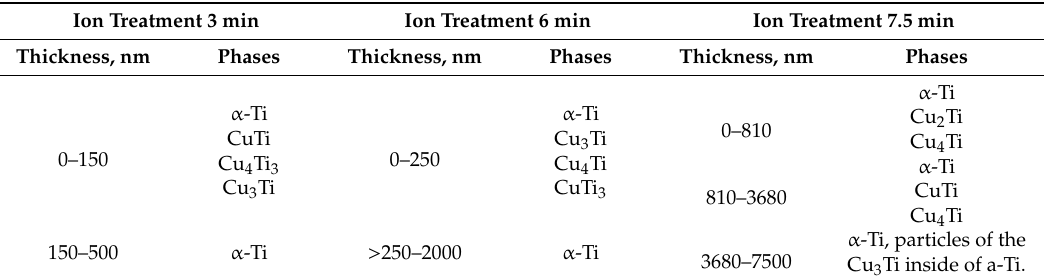
Table 4. Phase composition and thickness of Ti modified by Cu